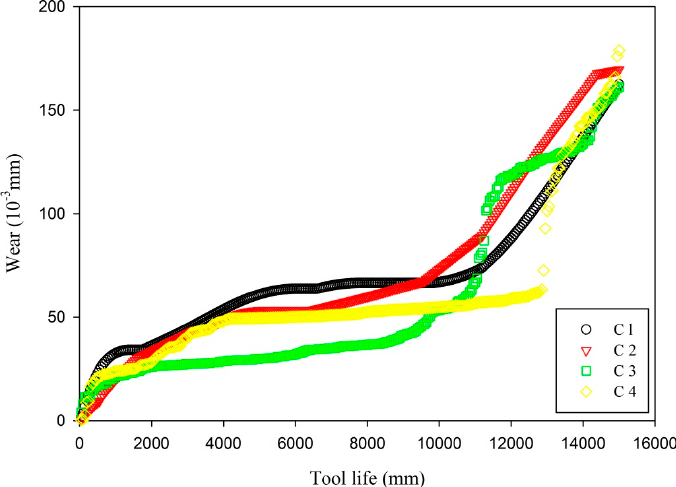
Figure 11. The correlation of the tool life and the tool wear.